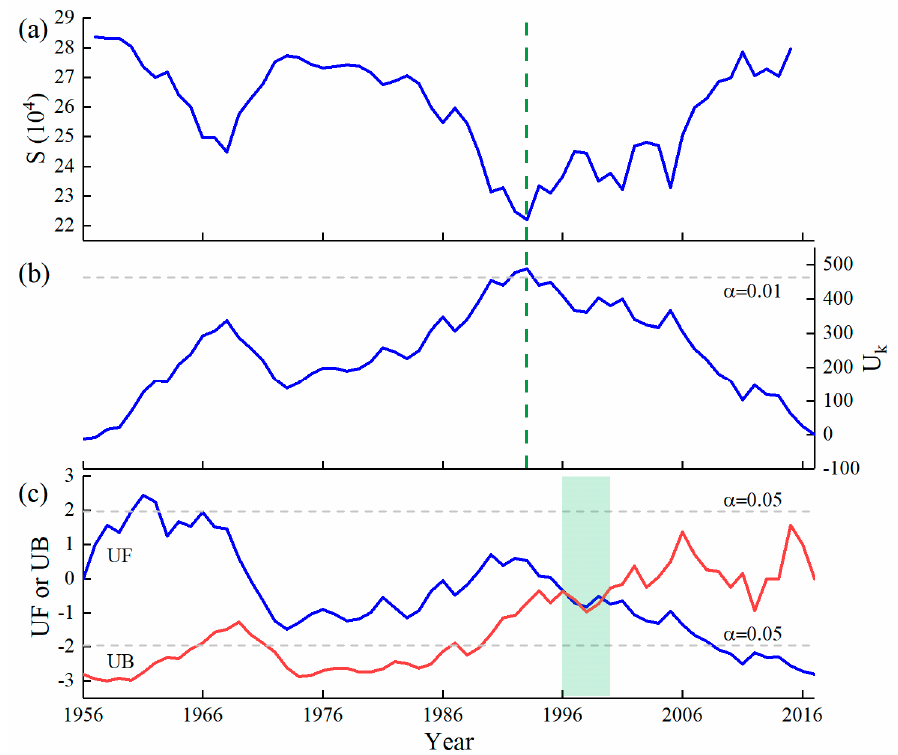
Figure 1. Three different abrupt change test methods were used to identify the change point of annual runoff in Minjiang watershed from 1956 to 2017: ( a ) is the result of order cluster analysis and the identified change point was in 1993; ( b ) is the result of Pettitt’s test and the identified change point also appeared in 1993 ( α = 0.01); ( c ) is the result of the Mann–Kendall test and the change point location is between 1996 and 1999 ( α = 0.05). S is the statistic of order cluster analysis, U k is the statistic of Pettitt’s test, UF and UB are the statistics of Mann-Kendall test.